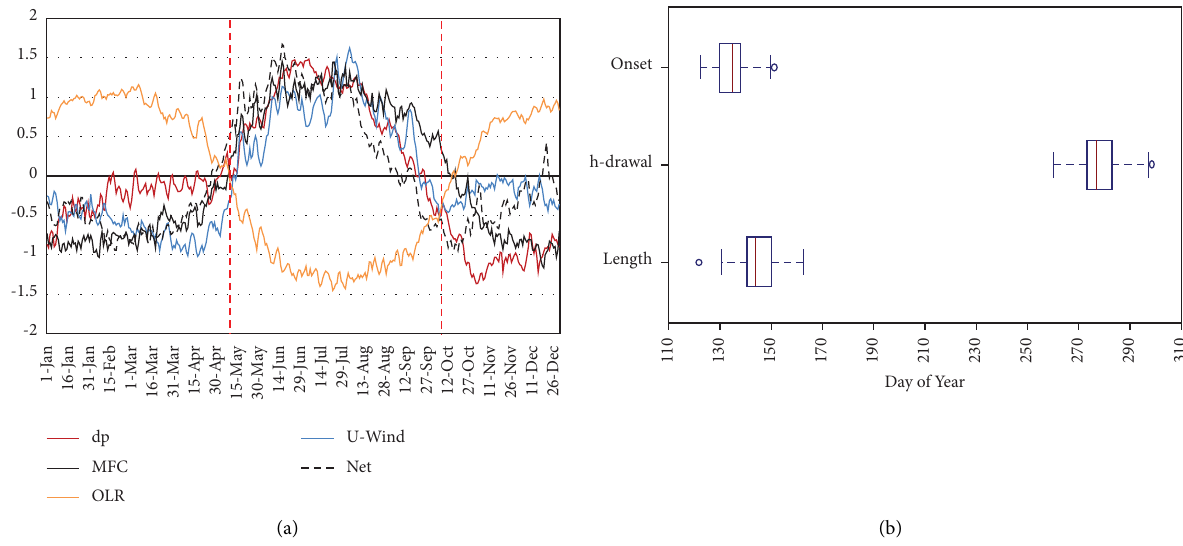
Figure 4: (a) Climatology time series of ERA-5 daily atmospheric mean sea level pressure diferential averaged of northern (Putao region and southern parts (Kaw Taung region, 25–30 ° N, 95–100 ° E) (solid red) over 10–15 ° N, 90–100 ° E during (Jan 1st, 1991–Dec 31st, 2020), the mean U -850 wind diferential averaged as abovementioned regions (solid blue), MFC (solid black), net precipitation amount (dotted black), and CMFC (red) averaged over 10–28 ° N, 92–102 ° E. Vertical dashed red lines indicate the onset and withdrawal days in the year. (b) Te seasonal onset, withdrawal, and season lengths are plotted using the MSwM box-and-whisker method. With a red median line and whiskers indicating the total range, the blue boxes show the range between the 25th and 75th